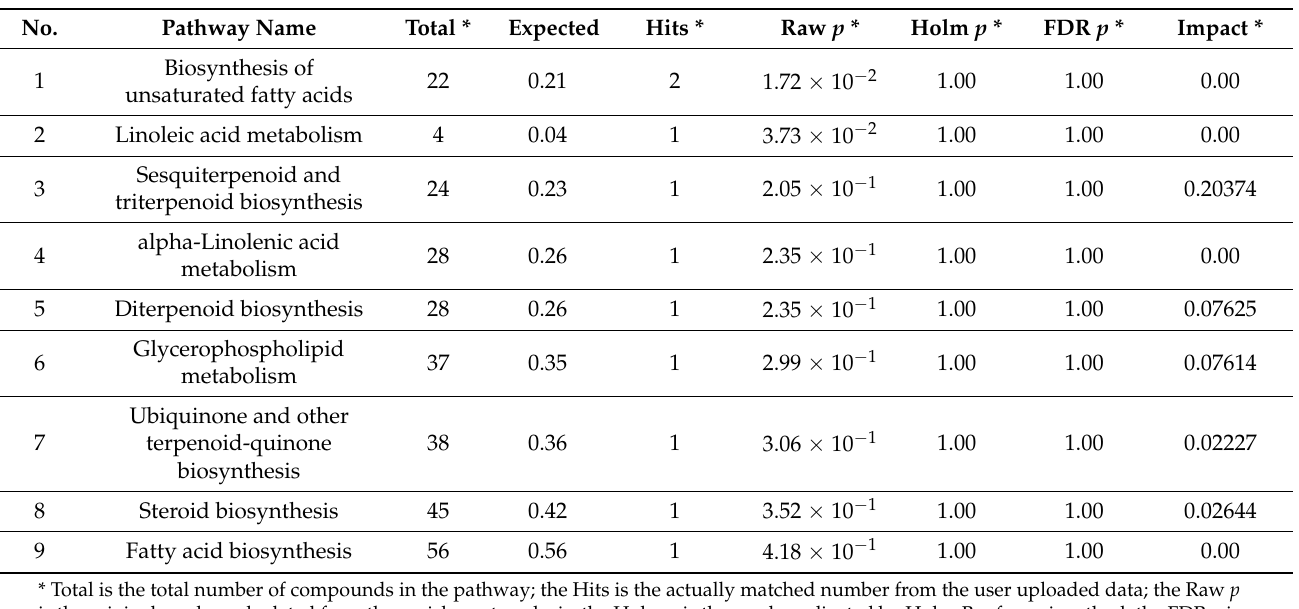
Table 3. Results from Pathway Analysis with MetaboAnalyst.